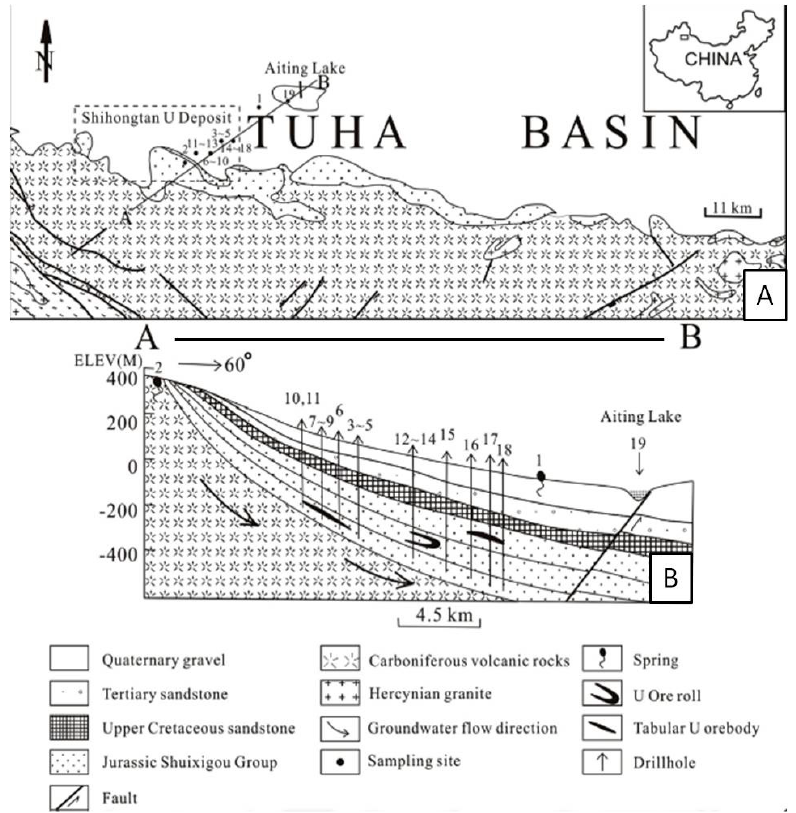
Figure 1. Simplified maps showing ( A ) the regional geological setting; and ( B ) the sample locations in hydrological cross-section of the Shuixigou-Group aquifer from the Shihongtan U ore district. From Min et al. [22].